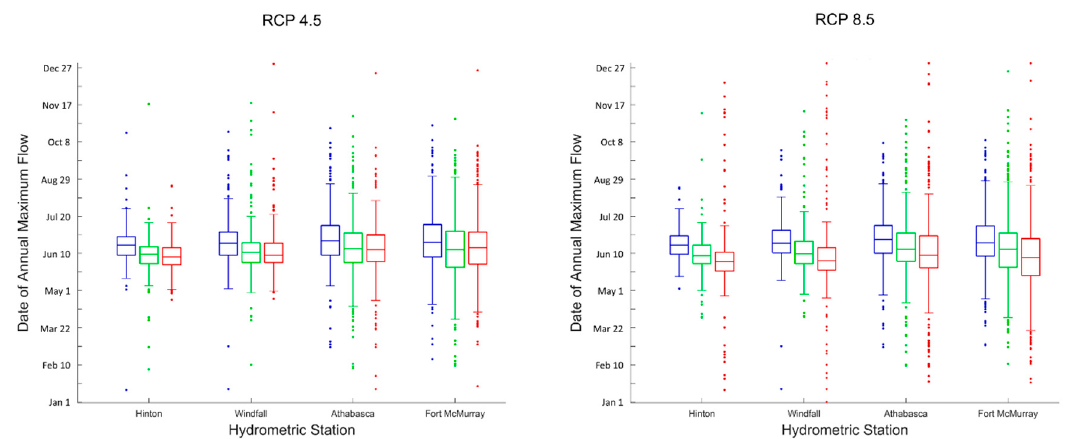
Figure 4. Box-and-Whisker plots of the dates of annual maximum flow series (AMS) corresponding to the two emissions scenario (RCP4.5 and RCP8.5) as simulated at each of the four hydrometric stations along the Athabasca River for the baseline (1990s, blue) and the two future periods (2050s (green) and 2080s (red)).